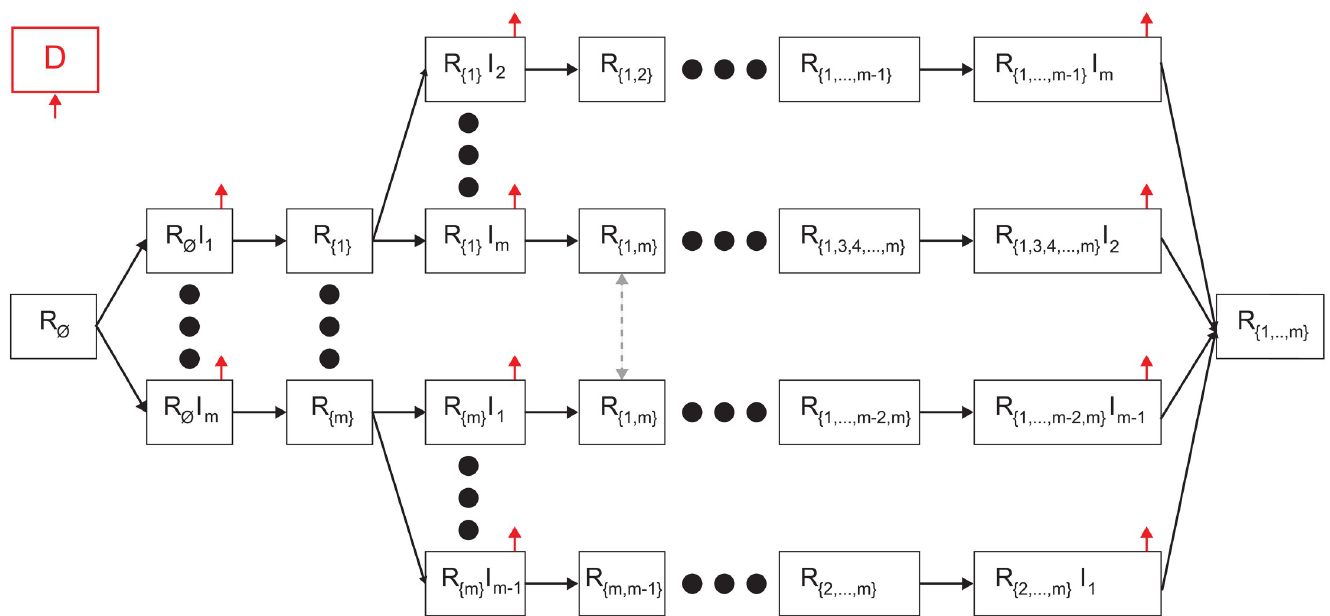
Fig 1. Schematic view of transition between disease stages. The red arrows indicates that individuals from the source stage can be transferred to the dead stage. Individuals in R J I i stages are necessarily transferred to the respective R J [ i stages (or dead stage), while individuals in the R J stages move to R J I l stage if they are infected by an individual that is infectious in strain l 2 M .